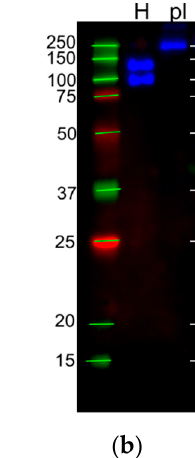
Figure 6. Results of reverse transcription PCR with RNA isolated from platelets (pl), MEG01, and HUVEC cells. M—size marker (50, 100, 150, 200, 250, 300, 400, 500, 600, 700, 800, 900, 1000 bp), K-—negative control. Arrows indicate fragments missing or poorly represented in HUVEC.